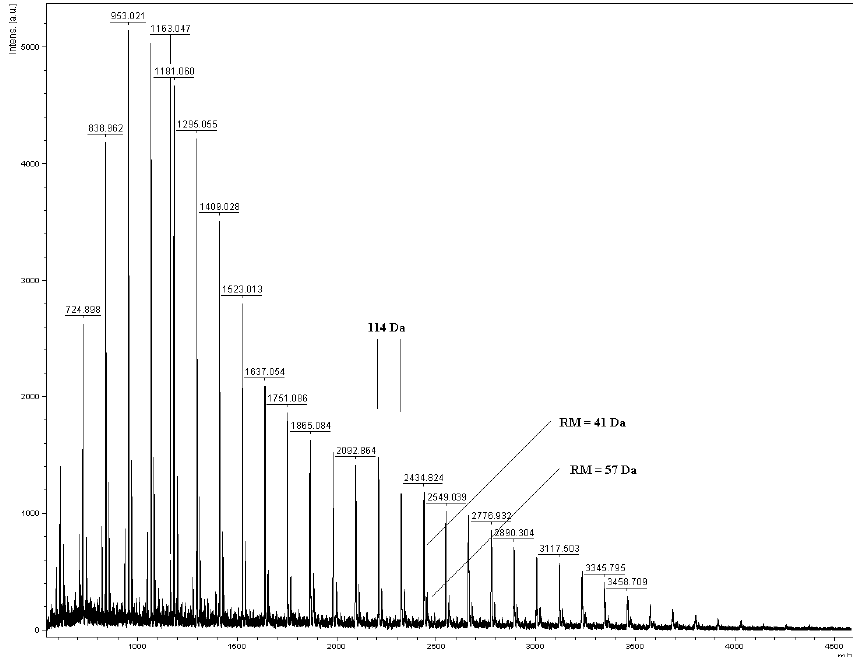
Figure 1. The MALDI TOF spectrum of the product of the CL polymerization in the presence of CE (Table 1, run no. 3).